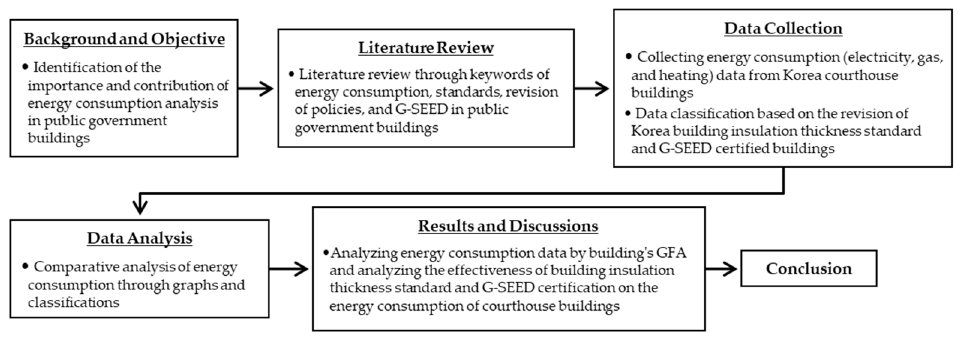
Figure 1. Research Figure 1. Research flowchart.